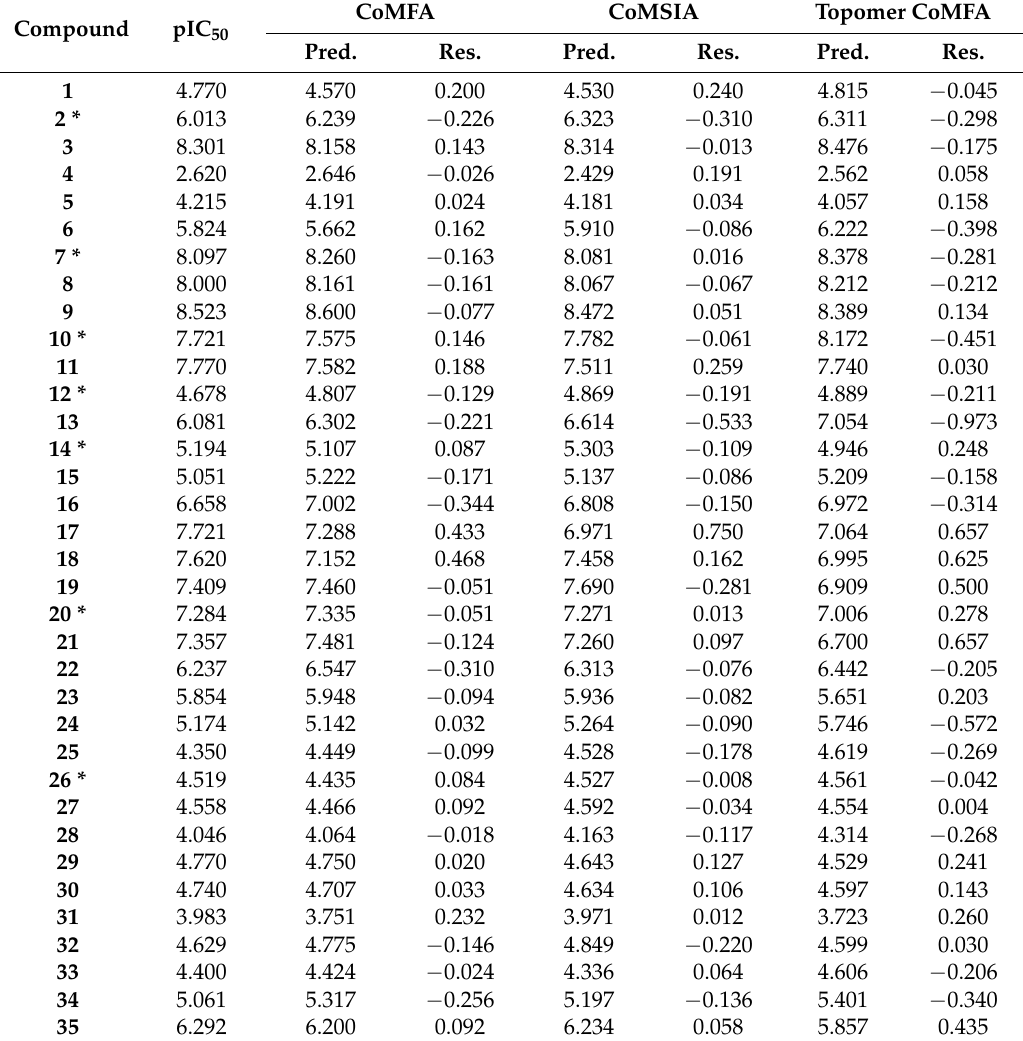
Table 3. The actual and predicted pIC 50 values of the dataset compounds.